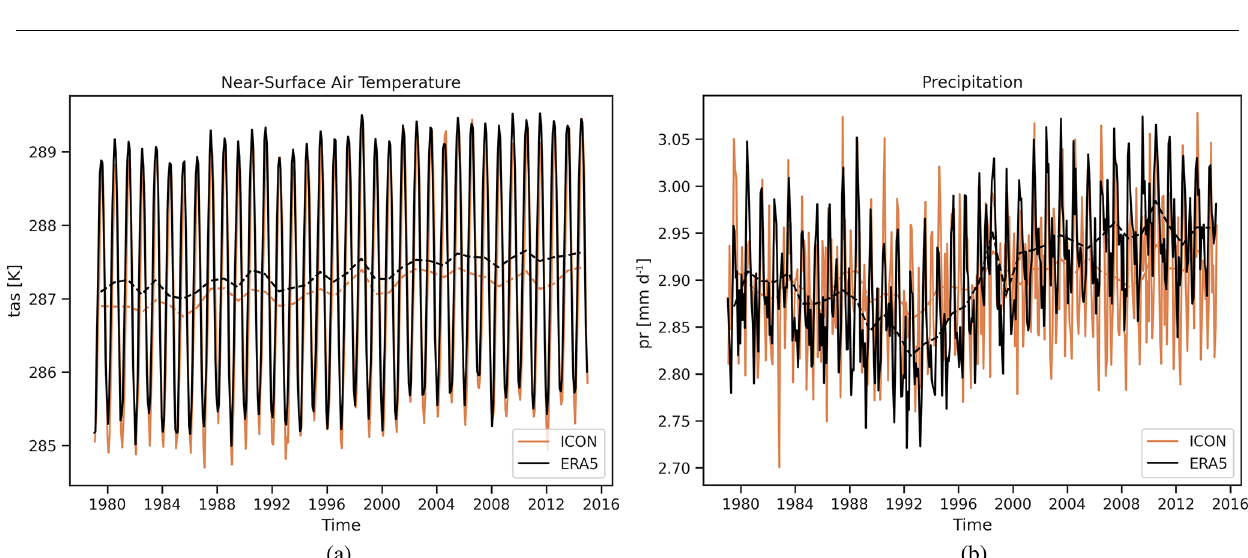
Figure 3. Monthly mean (solid lines) and annual mean (dashed lines) time series of ICON-ESM (orange) and ERA5 (black) for the period 1979 to 2014. The ICON simulation shown here (called “Cool Ruby”) is based on a standard AMIP setup at R2B4 resolution (about 160km) with an advanced representation of soil physics and properties. (a) Global mean near-surface air temperature. (b) Global mean